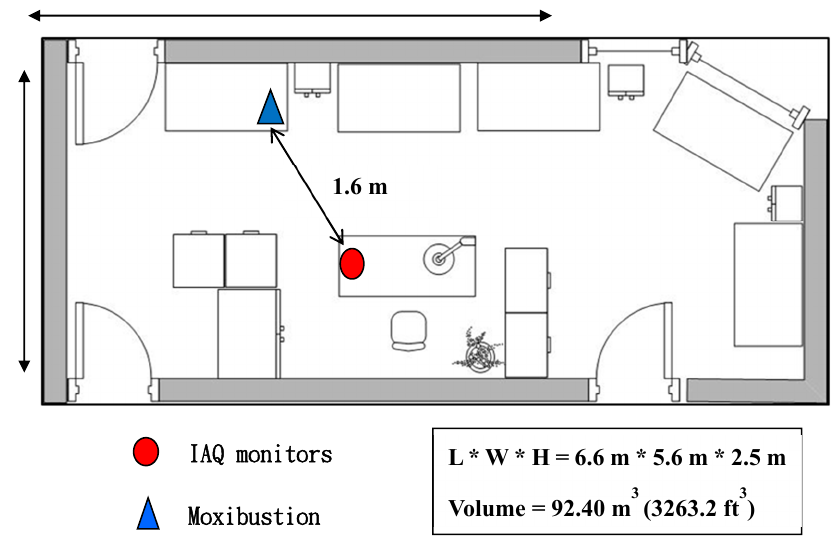
Figure 1. Diagram of the acupuncture and moxibustion room of the hospital.